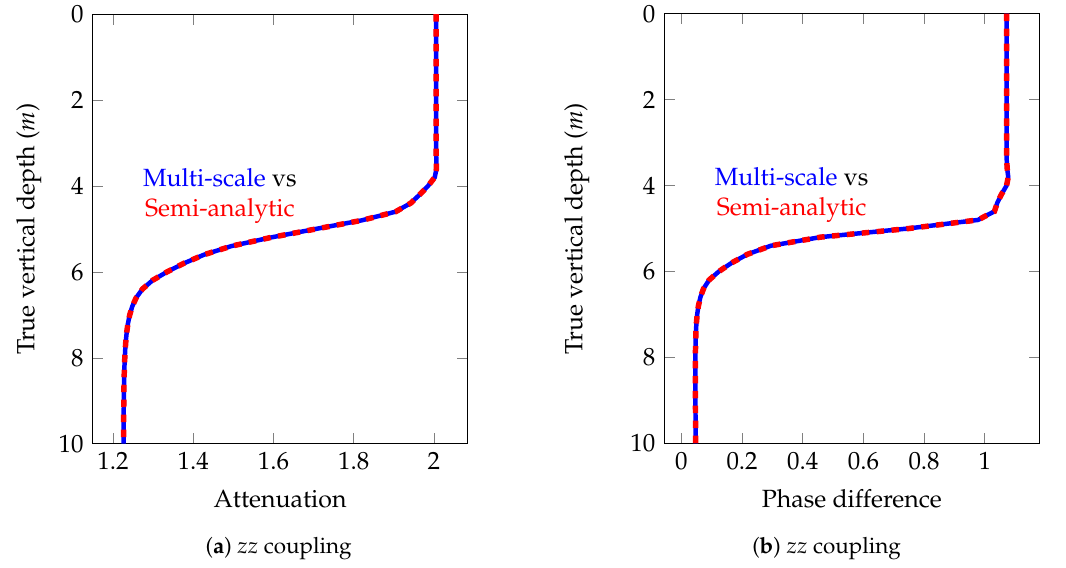
Figure 19. Model problem 3. Attenuation and Phase difference of the magnetic field for a vertical well (dip angle = 0 ◦